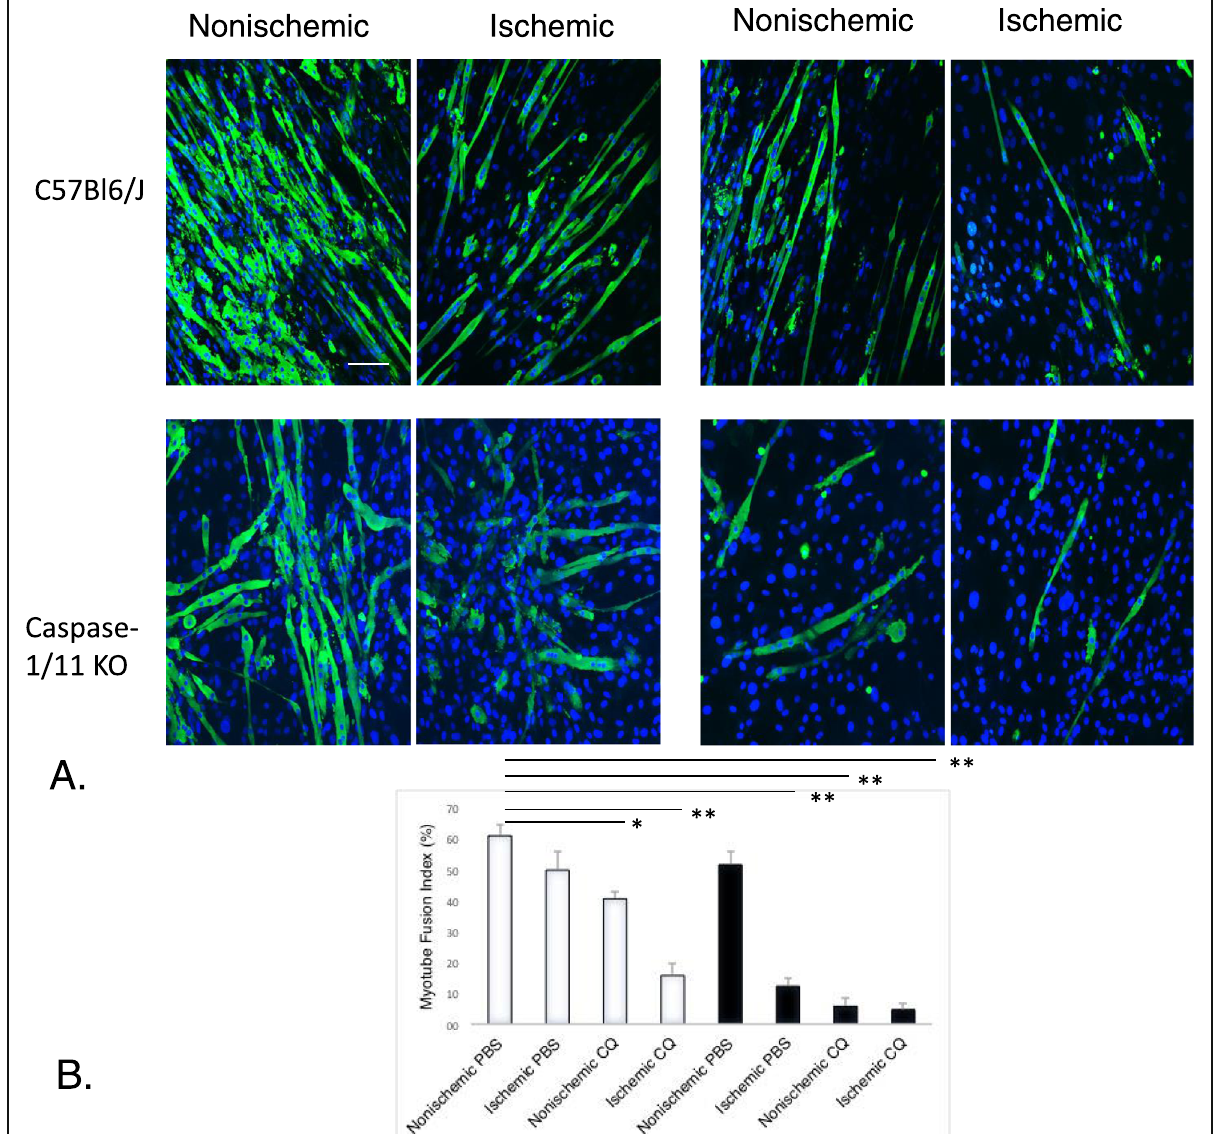
Fig. 8 Myocyte fusion index (MFI) is attenuated in ischemia, CQ and absence of caspase-1/11 ( a ) Immunofluorescence of MF20 (green) and with DAPI (blue) in muscle stellate cells (MuSC) 5 days after harvest from tibialis anterior (TA) of nonischemic and ischemic limbs of C57Bl6/J (WT) and caspase-1/11KO mice at 21 days after FAL treated with either PBS or CQ. ( b ) Myocyte fusion index (MFI) quantified as number of nuclei within multinucleated fibers (> 3 nuclei) dividing by total number of nuclei. C57Bl6/J (WT) (white bars) and caspase-1/11KO (black bars) * p < 0.05, ** p = 0.01, *** p < 0.001; N = 4 mice per strain per treatment group; Scale bar = 10 μ